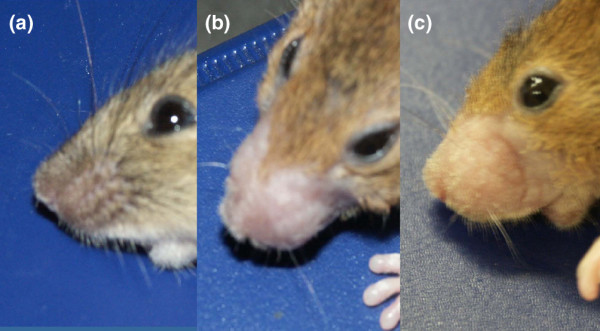
Nasal chondritis during spontaneous polychondritis in DQ6α8β transgenic expressing mice. Representative (a) uninflamed and (b), (c) inflamed noses from mice with spontaneous polychondritis. Redness, swelling and accompanying hair-loss was observed in approximately 23% of the DQ6α8β transgenic expressing mice observed.